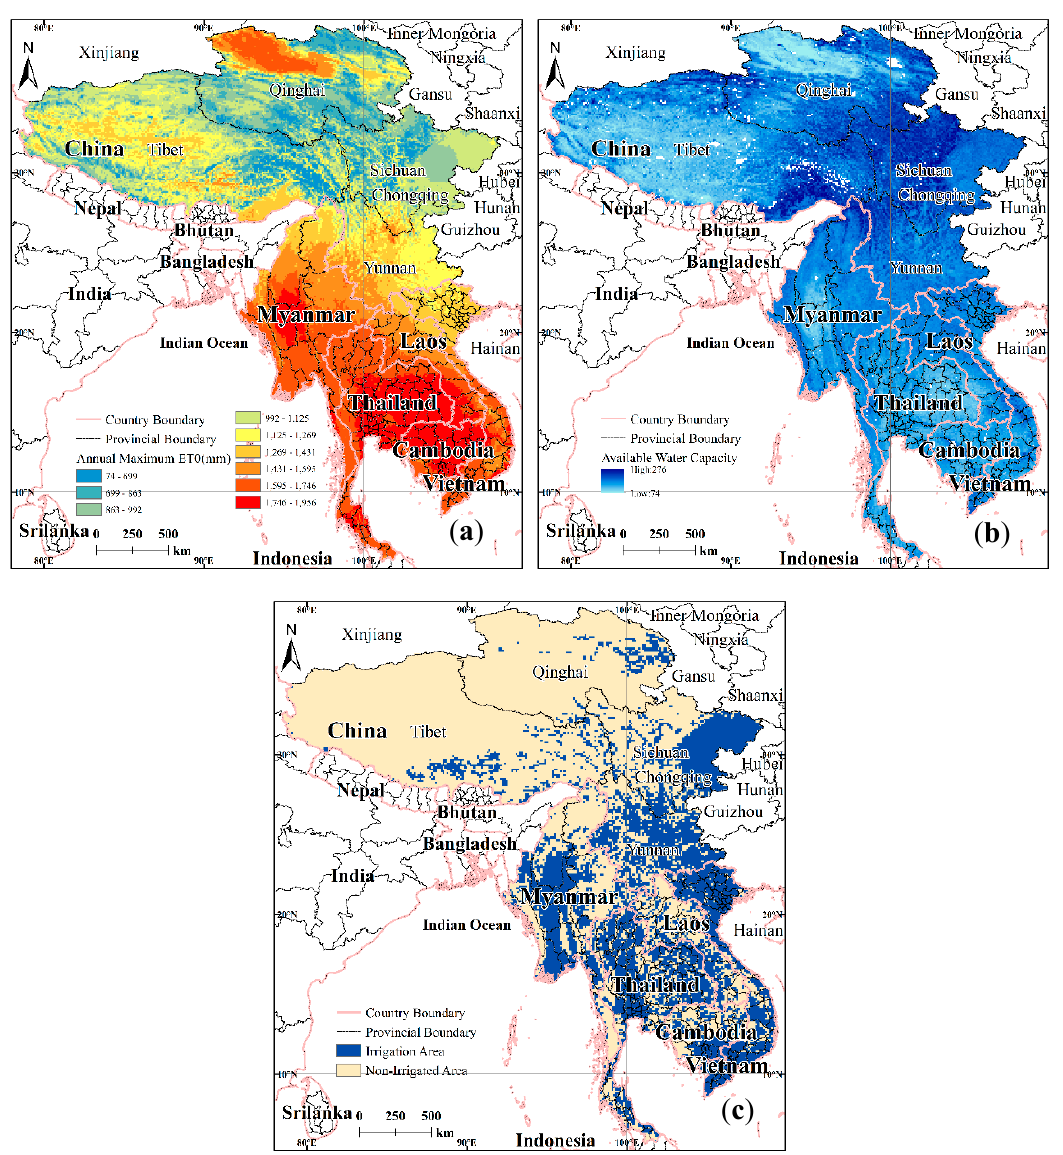
Figure 3. Evaporation of reference crops ( a ), available water capacity ( b ), and irrigation distribution ( c ) in the LMR.